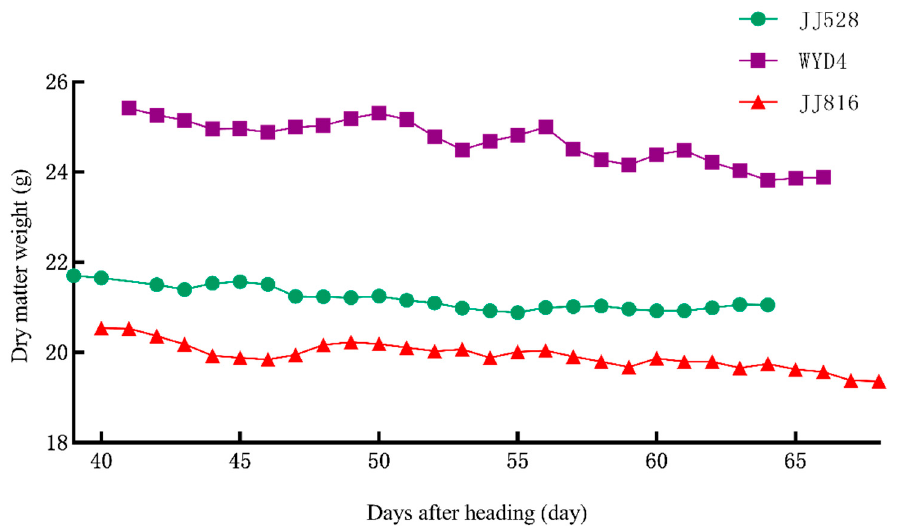
Figure 2. The relationship between rice dry weight and days after heading in 2019 was tested.